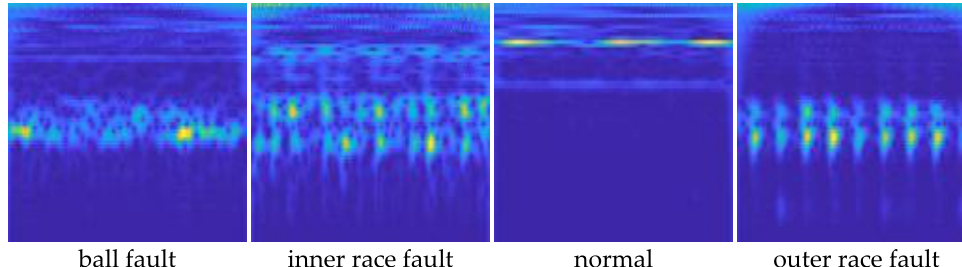
Figure 2. Four types of fault data.